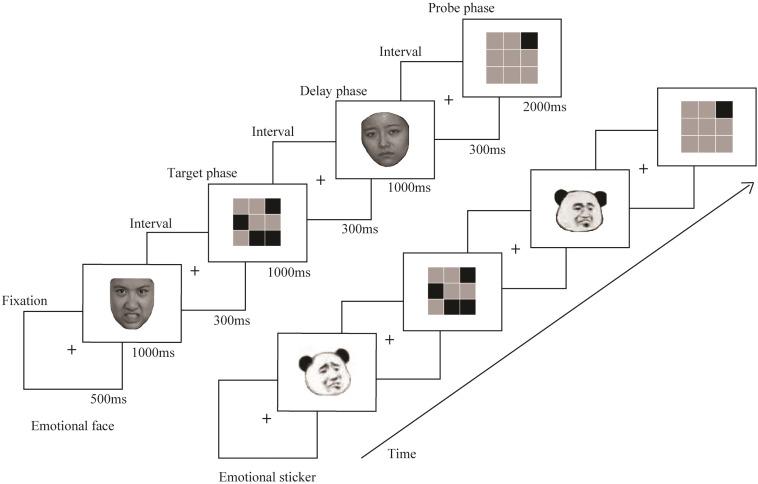
Design of the experimental paradigm.